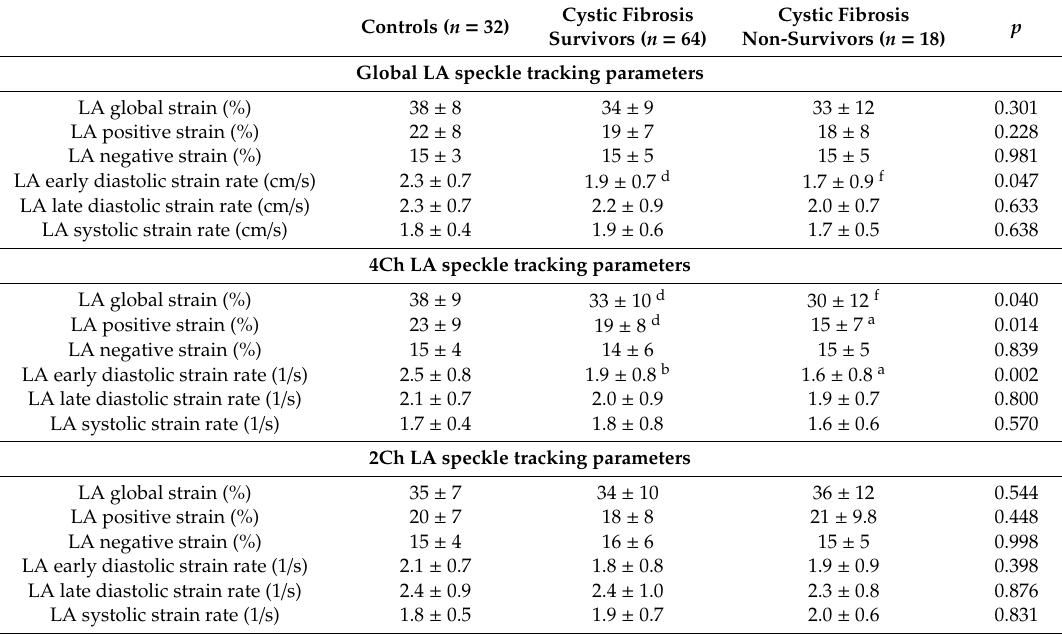
Table 3. Left atrial speckle tracking parameters.